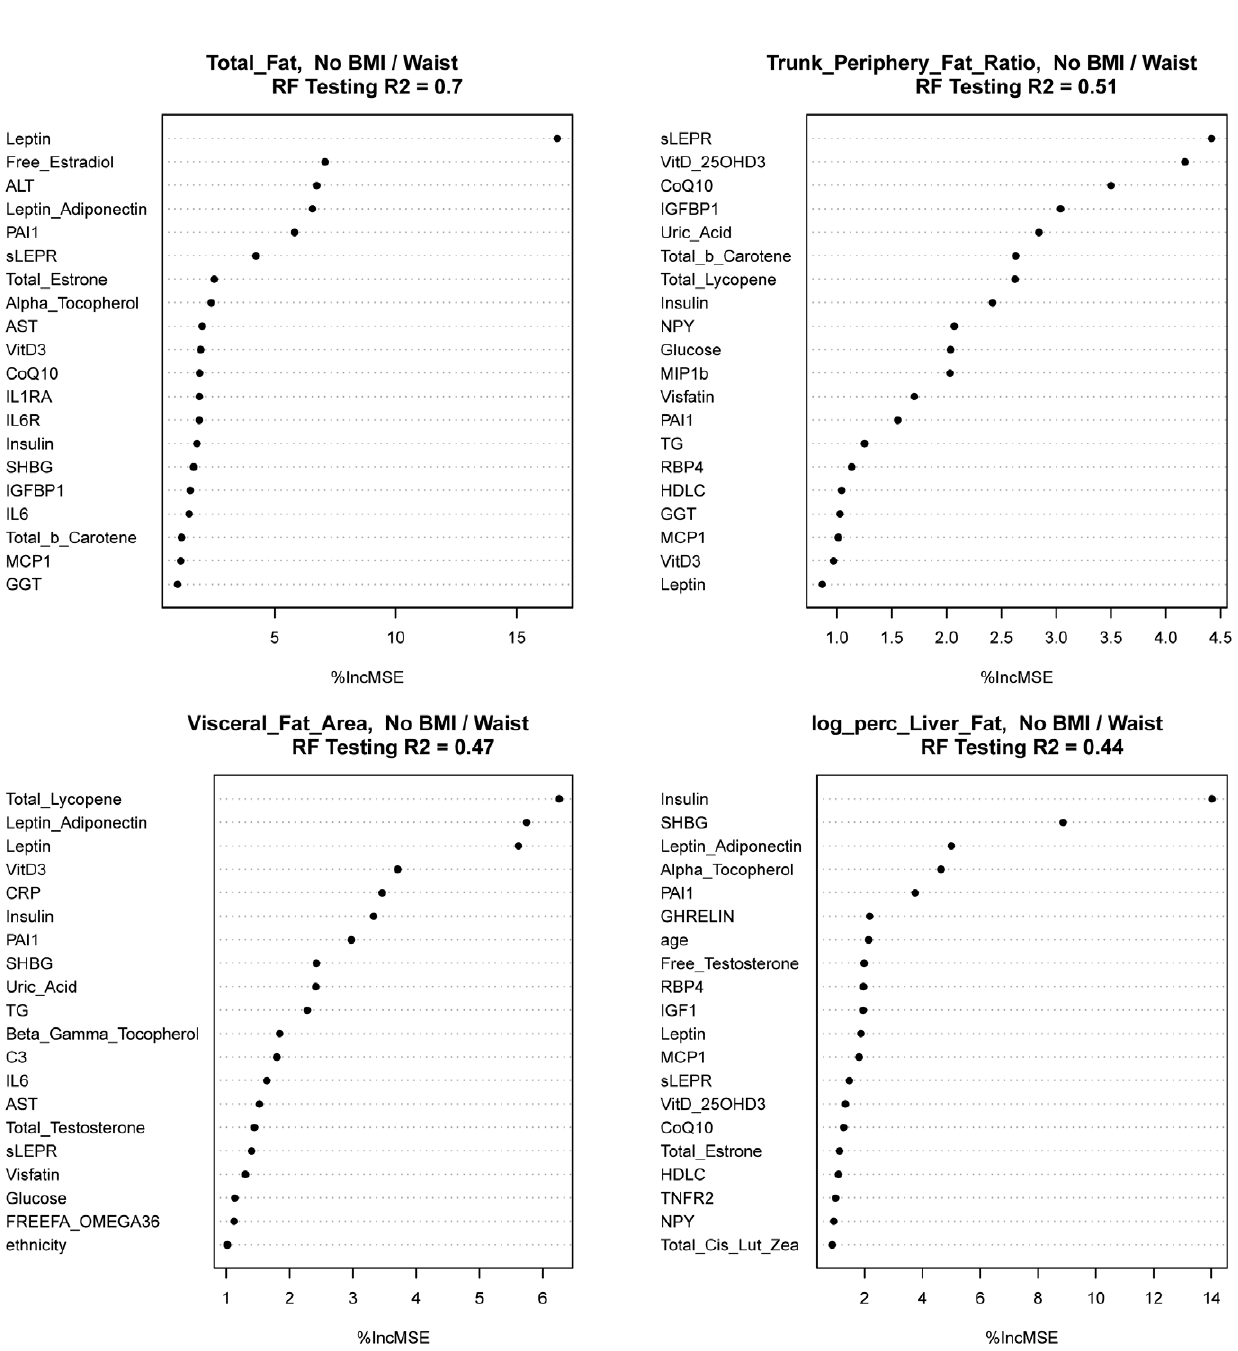
Figure 1. Random Forest models for predicting adiposity. Total, abdominal (trunk-to-periphery fat ratio or TPFR), visceral and hepatic adiposity measurements were predicted to various extent by a number of blood biomarkers, as well as by demographic (age, ethnicity, education) and key lifestyle variables (smoking, medication use, supplement use, parity), without anthropometric variables. Predictors were ranked by the importance score, which was based on percent increase in mean square error upon random permutation of the given predictor. The figure shows the top 20 predictors for each adiposity measure. (Abbreviations: BMI [body mass index], %incMSE (percent increase in mean square error), RF [Random Forest]; see Table S1 for the full names of the biomarkers).